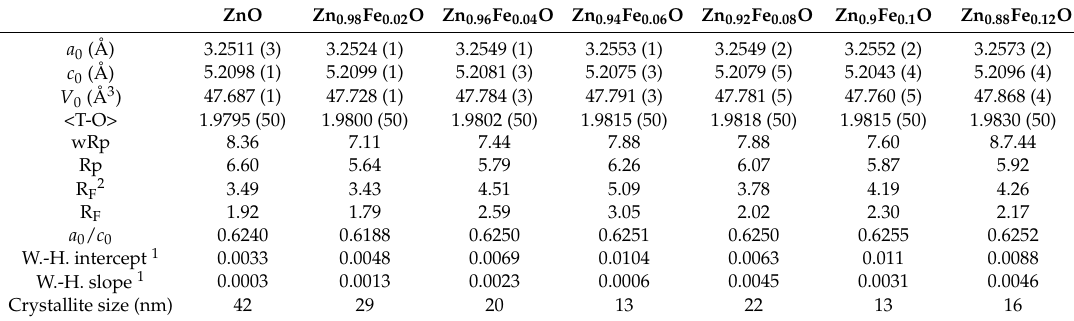
Table 1. Structural parameters, average crystallite size, and disagreement indexes of the Rietveld refinements performed using isotropic temperature factors and isotropic broadening of the diffraction reflections. The errors of the Unit cell parameters and <T–O> distances are provided in brackets.